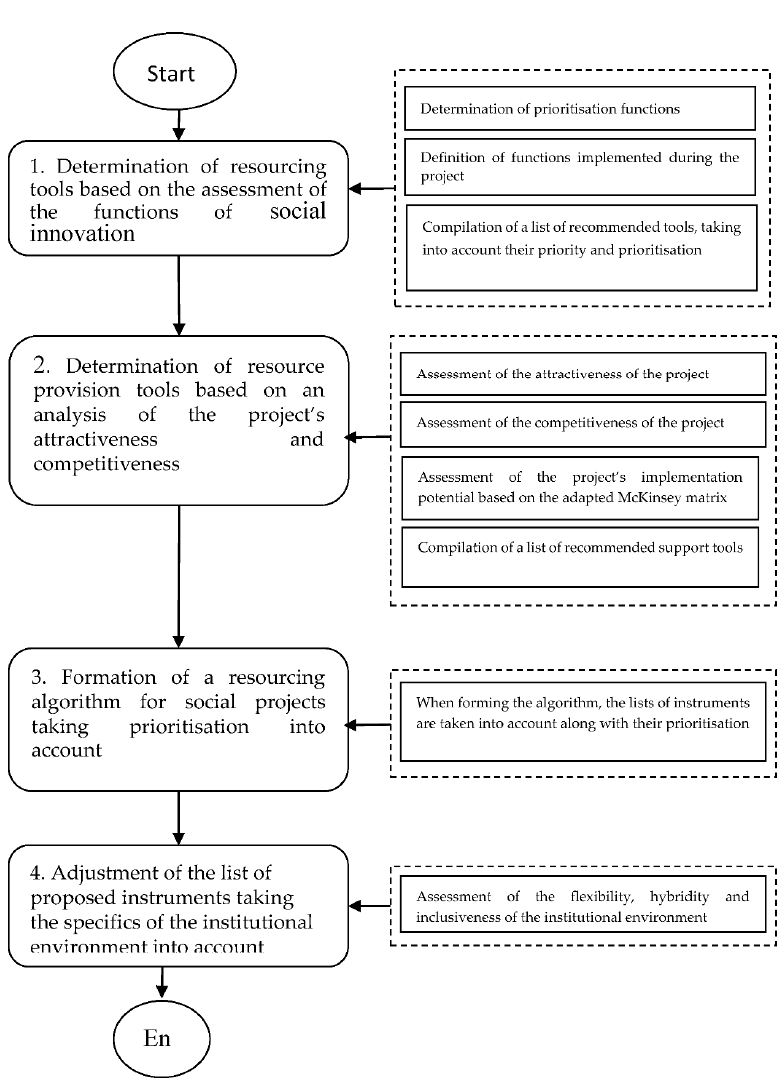
Figure 2. Algorithm for the formation of a resourcing strategy for a socially-innovative project.